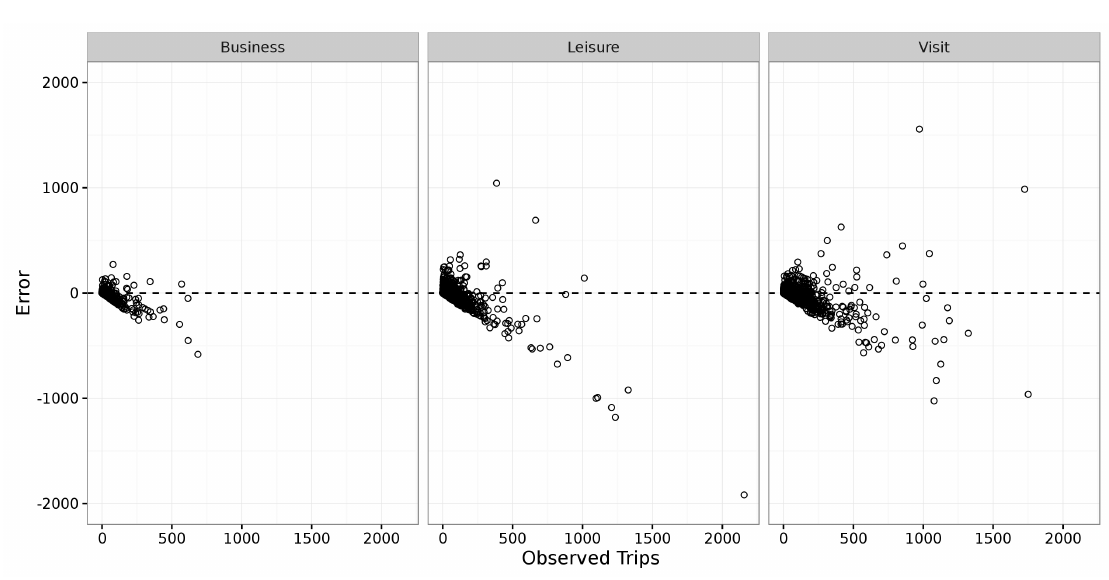
Figure 2. Model A: Errors by observed trip count for OD pairs by trip